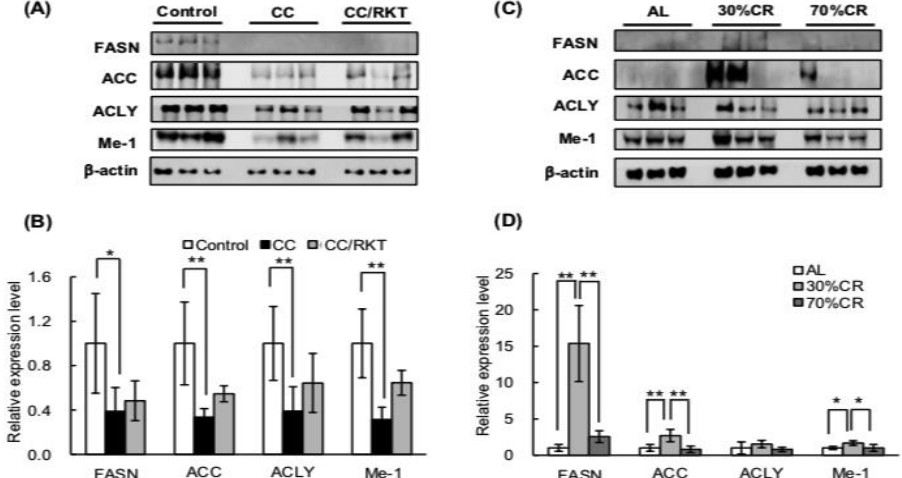
Figure 2. Effects of cancer cachexia (CC), rikkunshito (RKT), and caloric restriction (CR) on the protein expression of key lipases in epididymal white adipose tissue (eWAT). Western blot analysis of hormone-sensitive lipase (HSL) and adipocyte triglyceride lipase (ATGL) was performed using a chemiluminescence method. Lysates were prepared from eWAT of control, CC, and CC/RKT rats ( A , B ), rats fed ad libitum (AL) and subjected to CR ( C , D ). ( A , C ) Representative images of western blots. ( B , D ) Densitometry data for HSL and ATGL. The expression of each protein was normalized to β -actin protein expression. Error bars represent the SD associated with each mean ( n = 5–6). * p < 0.05, ** p < 0.01 by Tukey’s test.